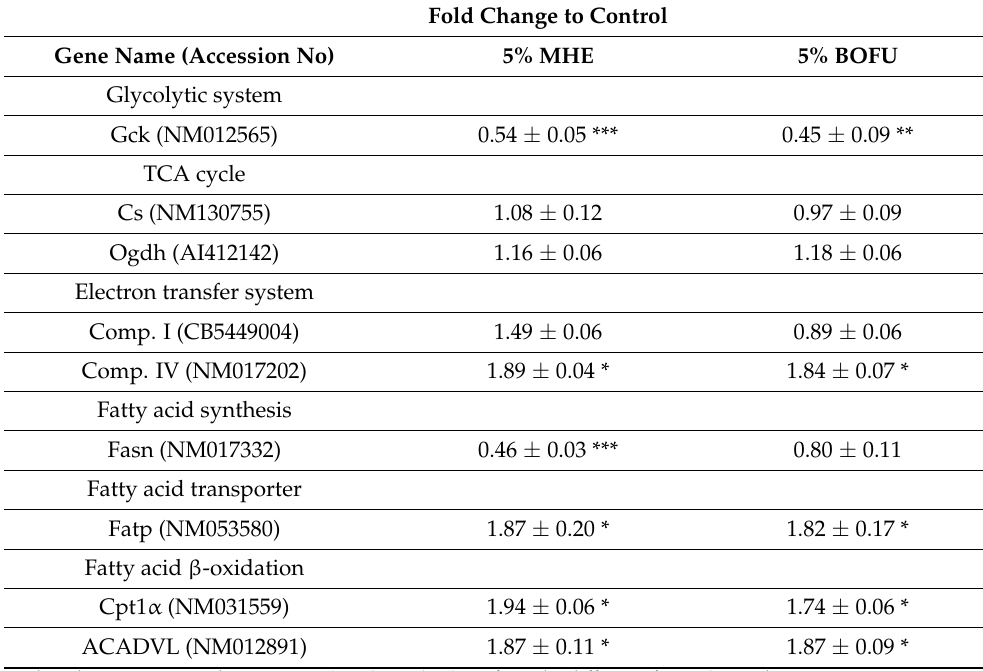
Figure 5. Effects of MHE and BOFU on body weight in HFD-fed rats. Table 7. Effects of MHE and BOFU on body and organ weight after four weeks of feeding. Table 8. Liver gene expression analysis by real-time PCR after four weeks of MHE and BOFU